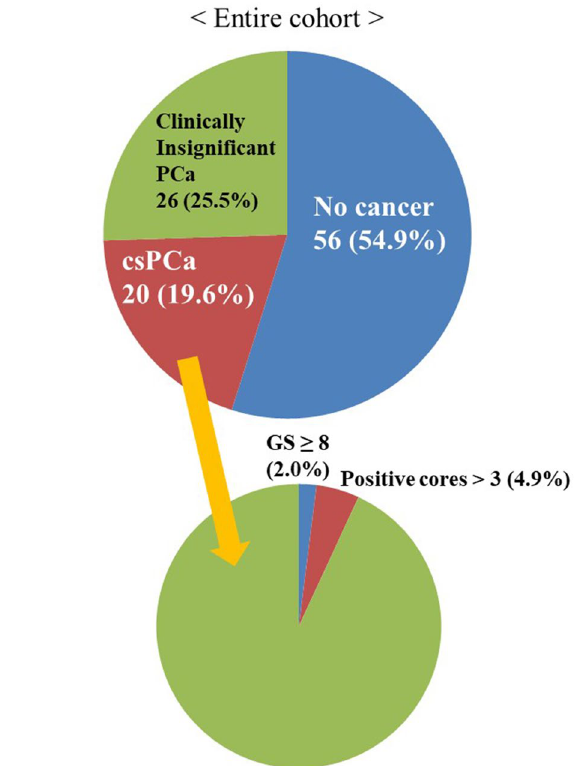
Figure 1. Patients with subsequent biopsy results.